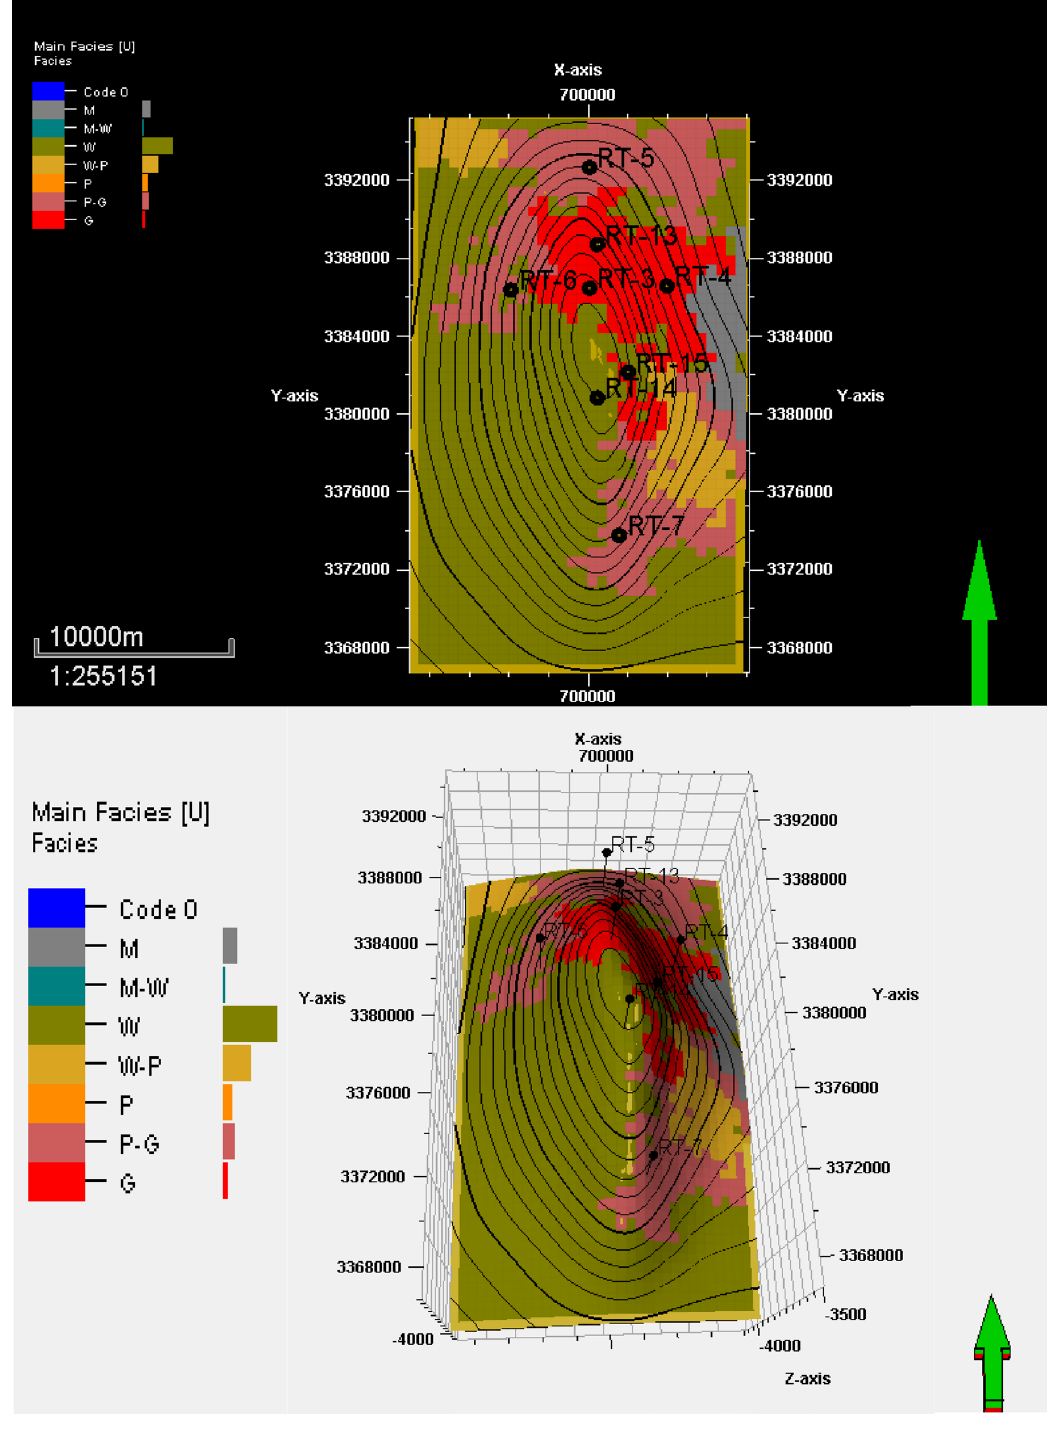
Figure 10. Facies distribution of the top surface of reservoir unit